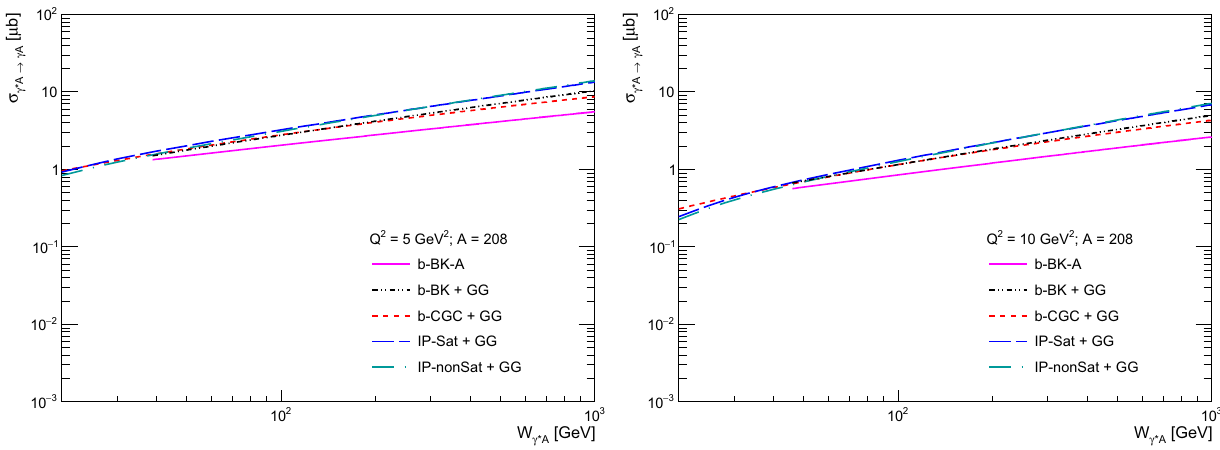
Fig. 5 Predictions for the t -distributions of the DVCS process in ep collisions at the EIC (upper panels) and LHeC (lower panels) derived considering distinct models for the dipole-proton scattering amplitude and different values of the photon virtuality